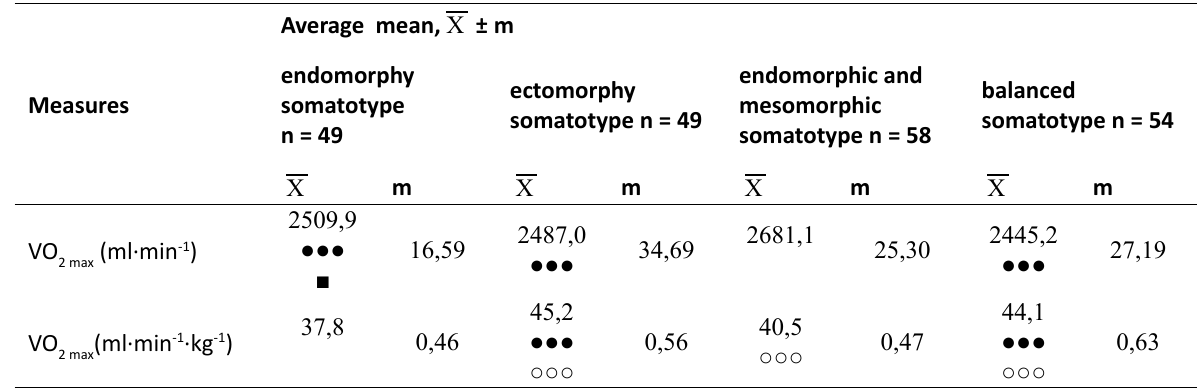
Table 1. Power measures of aerobic productivity and women body weight